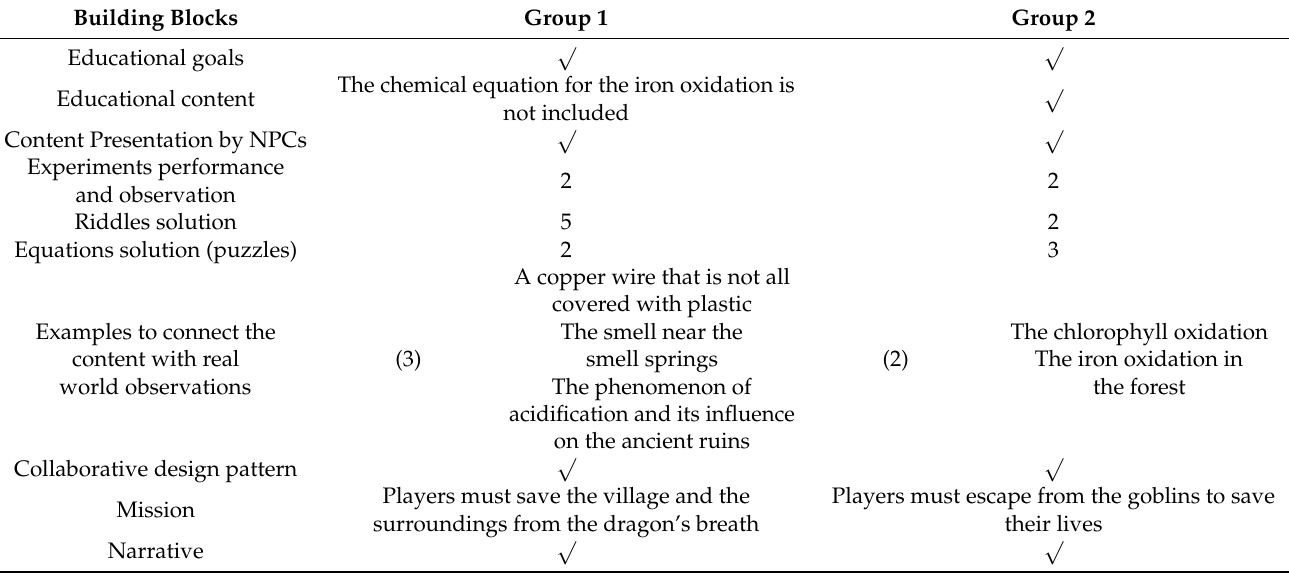
Table 6. Implementation of the Design Methodology in Case Study